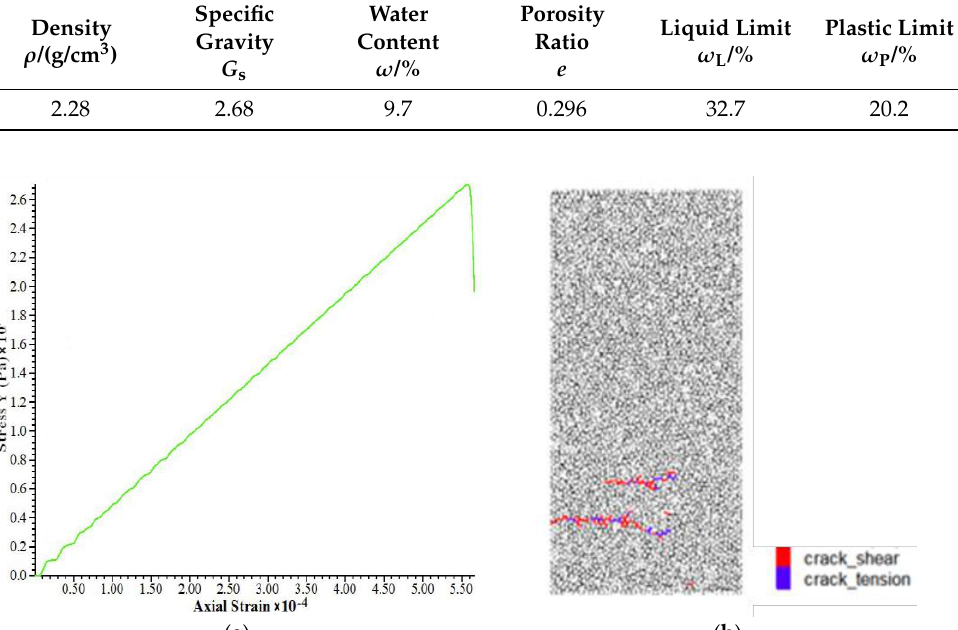
Figure 5. Force-displacement behavior of bonded-particle model. Modified after Potion and Cundall (2004) [13].